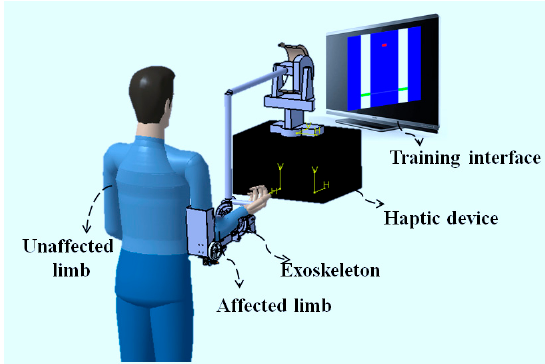
Figure 2. Bilateral rehabilitation training system.